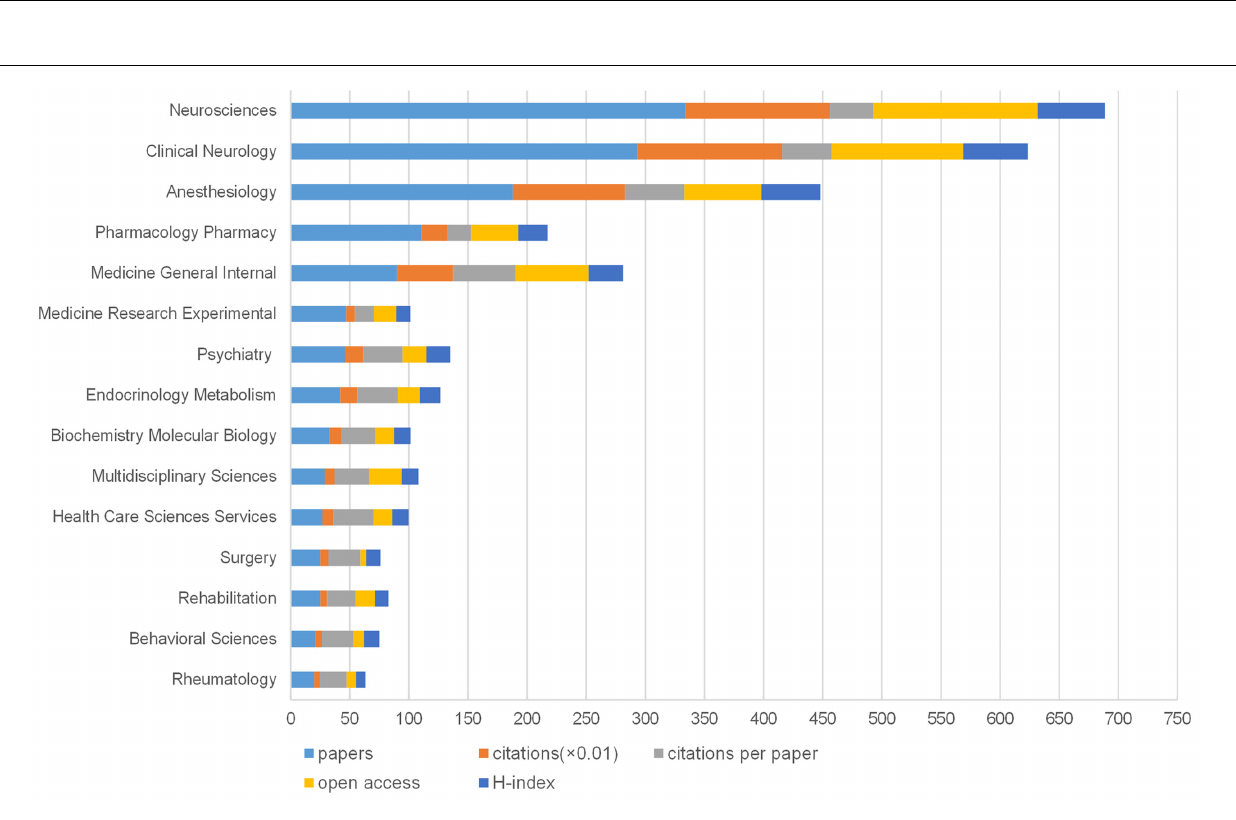
FIGURE 3 | The number of articles, citations, citations per paper, open access articles, and H-index of the top 15 subject categories of Web of Science.